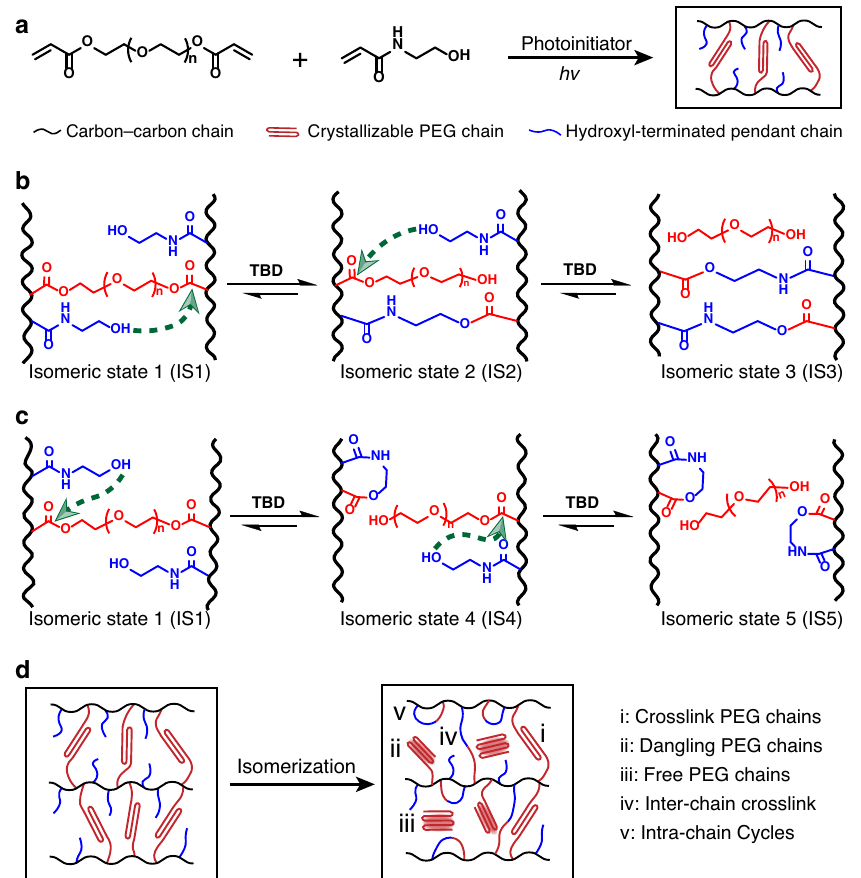
Fig. 1 Design of the dynamic covalent network and the mechanism of topological isomerization. a Polymer network synthesis. b Network isomerization via inter-chain transesteri fi cation pathways. c Network isomerization via intra-chain transesteri fi cation pathways. d Statistical outcome of the topological